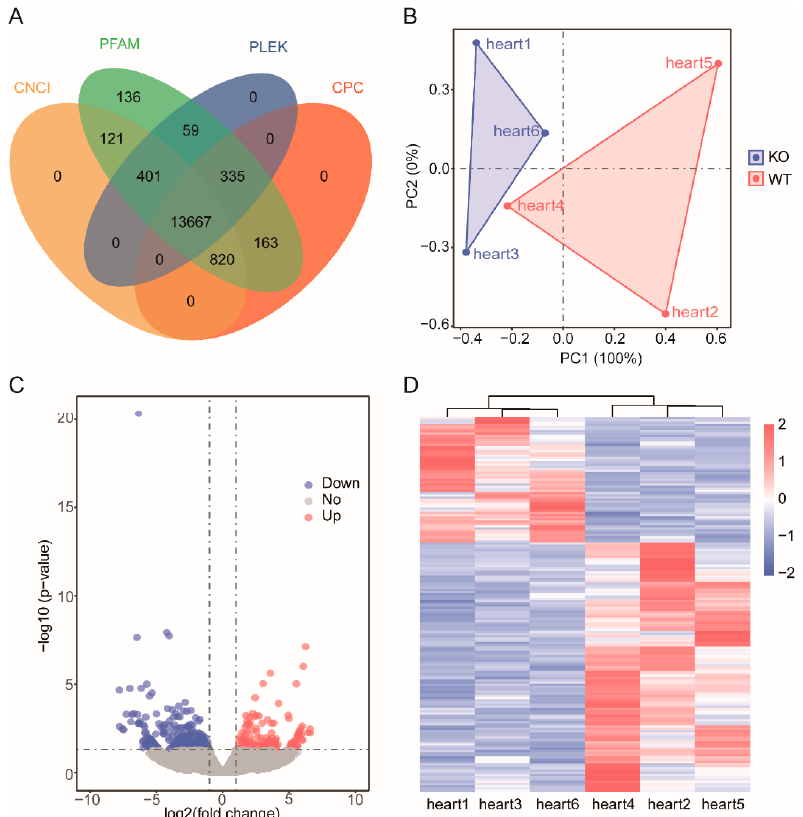
Figure 3. Statistical analysis of the noncoding genes. ( A ) Coding potentiality filter using Coding Potential Calculator (CPC), Pfam, PLEK, and Coding-Non-Coding Index (CNCI). ( B ) PCA of all expressed lncRNAs. Blue dots represent ZBED6 -KO samples, whereas red dots represent ZBED6 -WT. ( C ) Volcano plot of DELs. Blue represents down-regulated DEGs, and red represents upregulated DEGs. The horizonal dashed black line shows criteria of p -value equal to 0.05, while the vertical dashed lines show log2FC equal to − log1.5 (left) and log1.5 (right). ( D ) Hierarchical clustering of DEGs. The heavier the red is, the higher the difference in gene expression is, and the heavier the blue is, the lower the difference in gene expression is.